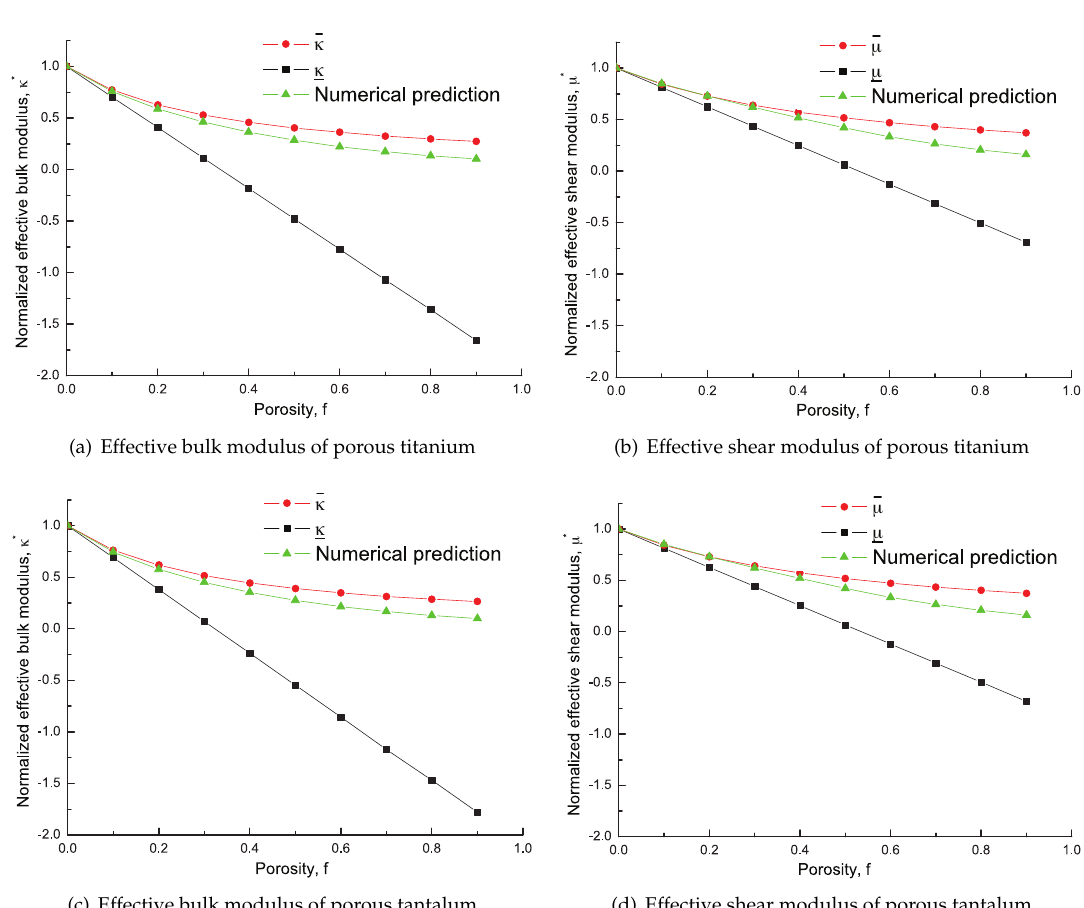
Figure 9. Normalized numerical predictions and theoretical bounds of the isotropic moduli of the porous tantalum and the porous titanium. The red and black lines are the upper and lower bounds of the elastic isotropic moduli; the green line is the numerical predictions obtained by our